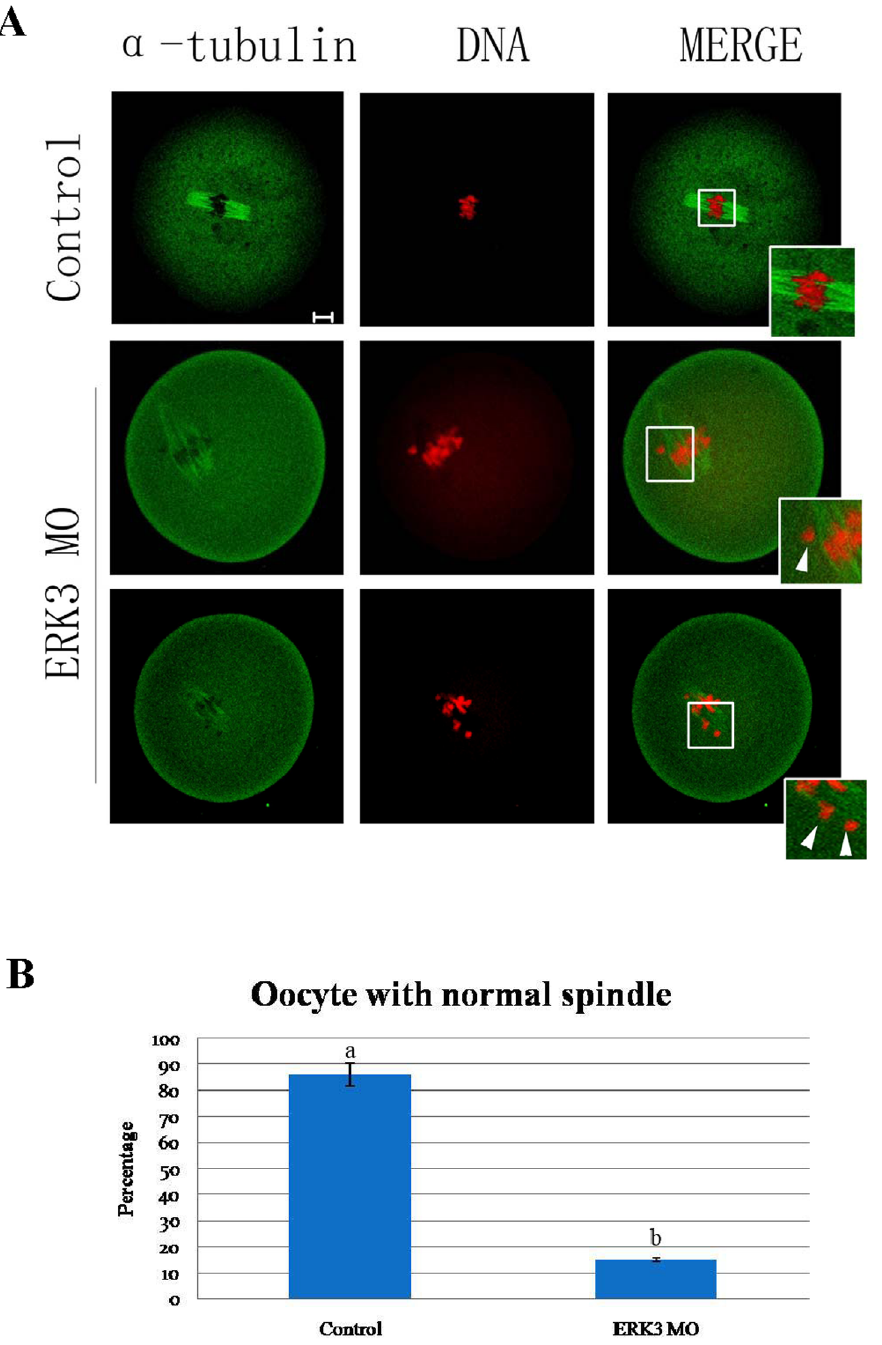
Figure 3. Deletion of ERK3 induced unstable microtubule-chromosome attachments at the MI stage. (A) Oocytes of control and ERK3 MO groups were cultured for 8.5 h followed by cold treatment for 10 minutes in M2 medium which was pre-cooled at 4 u C. Magnifications of the boxed regions show that all chromosomes were attached to microtubules in control oocytes, but not in ERK3 MO microinjected oocytes, whereas abnormal spindles were observed in ERK3 MO group. Bar=10 m m. (B) Percentage of oocytes with normal spindles in the ERK3 MO group (n=50) and control group (n=49). Data are presented as mean 6 SE. Different superscripts indicate statistical difference (p , 0.05). Bar=10 m m.